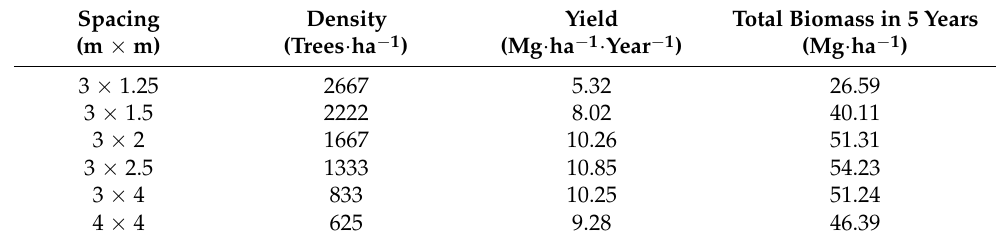
Figure 3. The average annual growth per individual at different planting densities. Note: The planting density ranges from 500 to 2500 trees · ha − 1 , rotation length from 3 to 6 growing seasons, and rainfall from 400 to 1200 mm. Table 4. The estimation of the biomass yield per hectare (Mg · ha − 1 ) for different planting